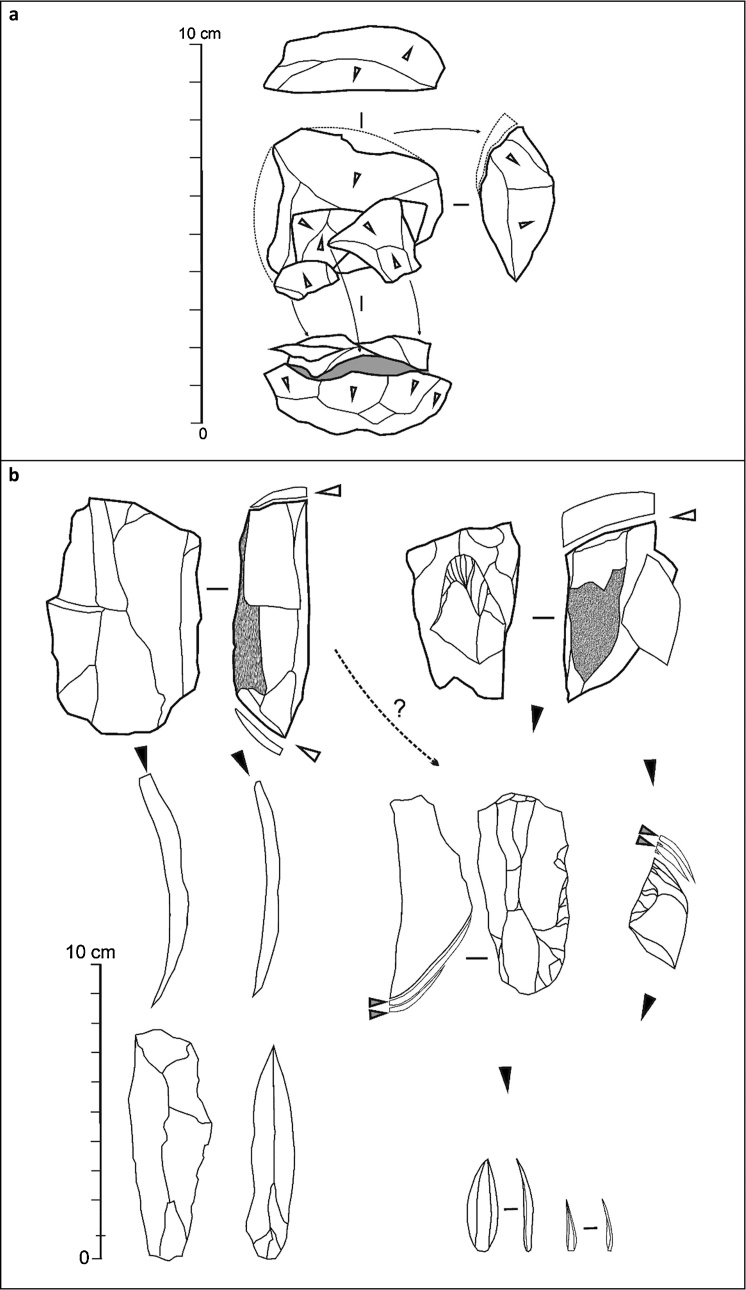
Core reduction methods across the Middle-to-Upper Paleolithic transition in the Mula basin sites. a. Simplified, schematic rendition of the approach to core reduction represented by the refitted material from Mousterian layer I-k of Cueva Antón (Fig. 10a); the refitting unit documents the endpoint, prior to discard, of the centripetal production of small flakes from a core previously exploited for similar blanks and in similar manner (as indicated by the shape and radial patterning of the flaking scars). b. Simplified, schematic rendition of the core reduction methods represented in the Evolved Aurignacian (OH20) of La Boja (Fig. 10b-c); two types of blades are extracted from prismatic cores — thin, to be used as a tool or as a blank for a retouched tool, and thick, to be used as a blank for bladelet cores of the carinated or nosed kind; thus, the latter’s intended end-products are bladelets obtained separately, not at the end of a continuous, blade-then-bladelet core reduction sequence.